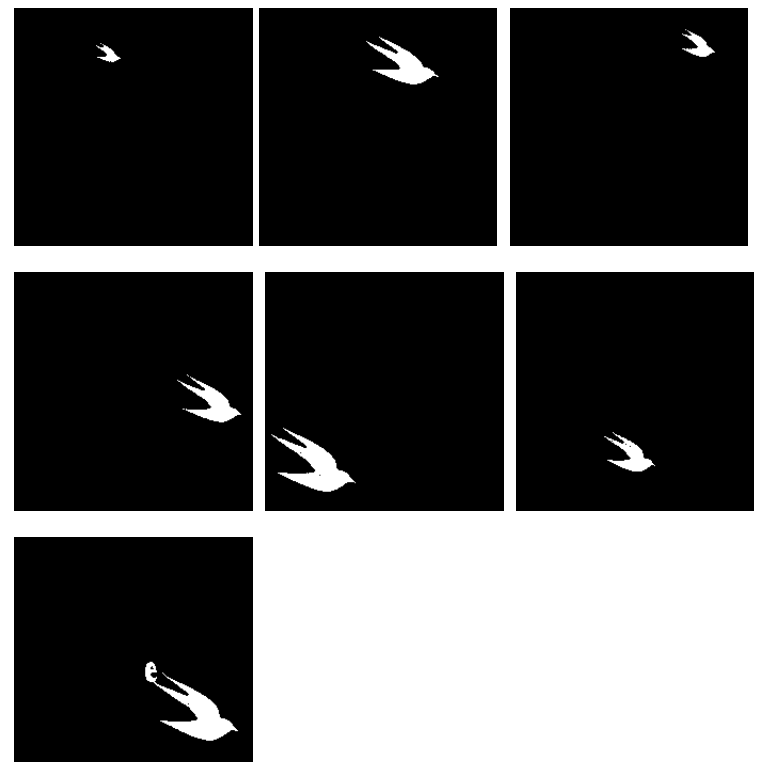
Figure 18. Experiment G extracted regions for d =